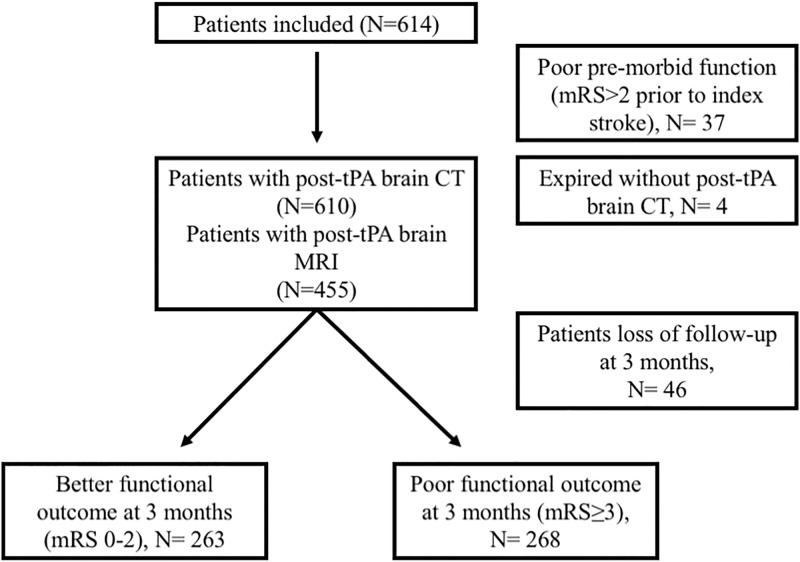
Flow chart of this study.Four patients were excluded in the association analysis of leukoaraiosis and SICH (Expired without post-tPA brain CT). Total 83 patients were excluded (poor pre-morbid function and loss of follow-up at 3 months) in the association analysis of leukoaraiosis and 90-day functional outcome. Note that all 455 patients with post-tPA MRI had post-tPA CT follow-up images, too.